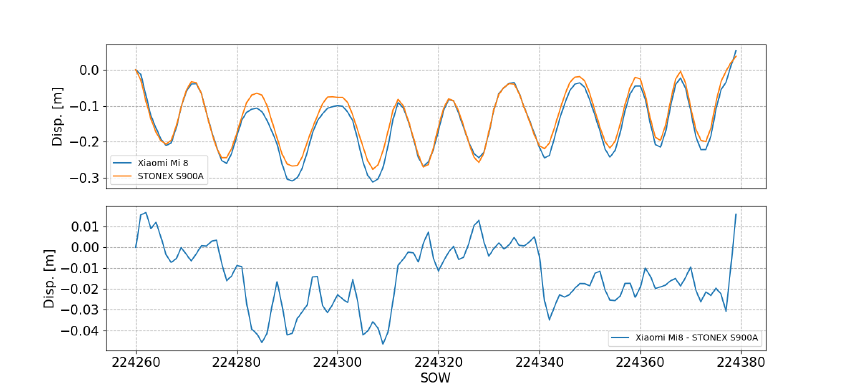
Figure 9. Time variation of 1D velocity and residuals with respect to the reference solution for the considered epochs.